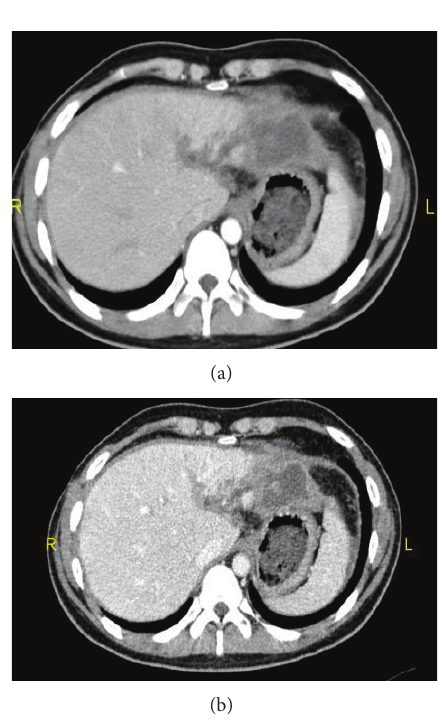
Figure 5: Follow-up abdomen CT (one year): (a) regeneration of right lobe and (b) shrunken left